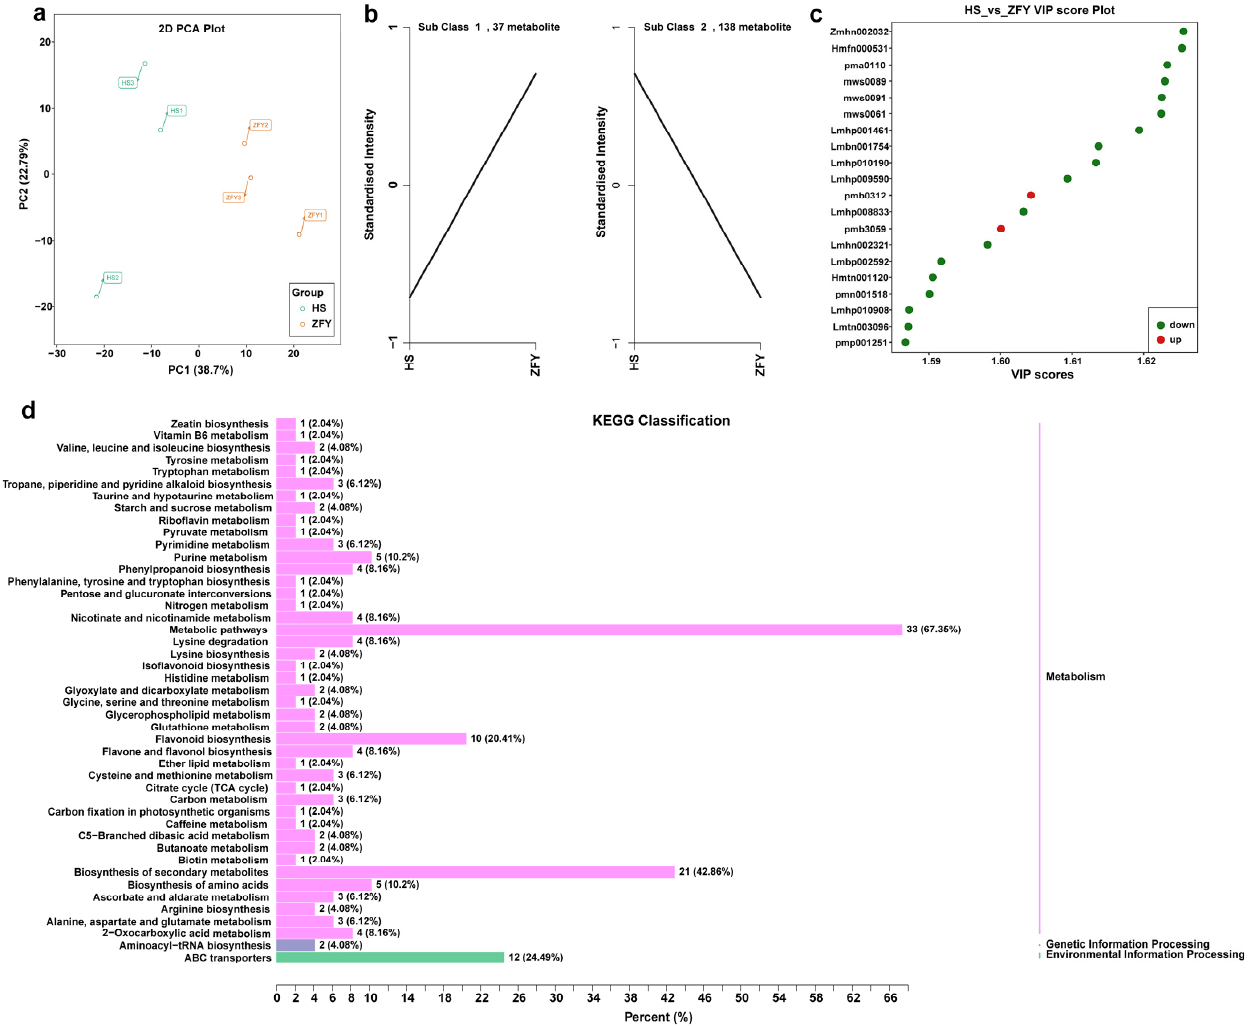
Figure 4. Metabolome analysis of HS and ZFY. ( a ) Two-dimensional principal component analysis (2D PCA). PC1 denotes the first principal component and PC2 denotes the second principal component. This percentage indicates the explanation rate of the principal component of the dataset. ( b ) K-means analysis showing trends in the relative content of metabolites in different subgroups. The mean values of the relative contents of di ff erential metabolites in each group were standardized using z-score and subjected to K-means clustering analysis. The horizontal coordinate indicates the name of the sample, the vertical coordinate indicates the relative content of standardized metabolites, the sub-class represents the number of metabolite classes with the same trend of change. ( c ) VIP score plot showing the results of di ff erentially expressed metabolites with the top ranked VIP values in the OPLS-DA model for each group comparison. Horizontal coordinates indicate VIP values, vertical coordinates indicate di ff erential metabolites, red represents upregulated di ff erentially expressed metabolites and green represents downregulated di ff erentially expressed metabolites. ( d ) KEGG pathway analysis of di ff erential metabolites. The vertical coordinate is the name of the KEGG metabolic pathway and the horizontal coordinate is the number of metabolites annotated to that pathway and their number as a percentage of the total number of annotated metabolites.